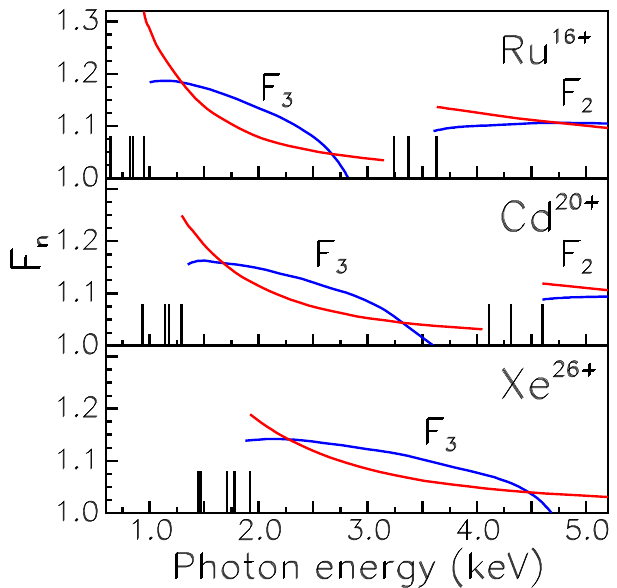
Figure 6. Enhancement factors F and F for the capture in the 4 p state of the Ni-like ions. 2 3 Red, present calculations; blue, exact non-relativistic calculations [31]. Vertical lines denote ionization energies obtained in the DF calculations. The lines relate from left to right to the 3 d and 3 d states merged together, the 3 p , 3 p , 3 s and the 2 p , 2 p , 2 s 5 / 2 3 / 2 3 / 2 1 / 2 3 / 2 1 / 2